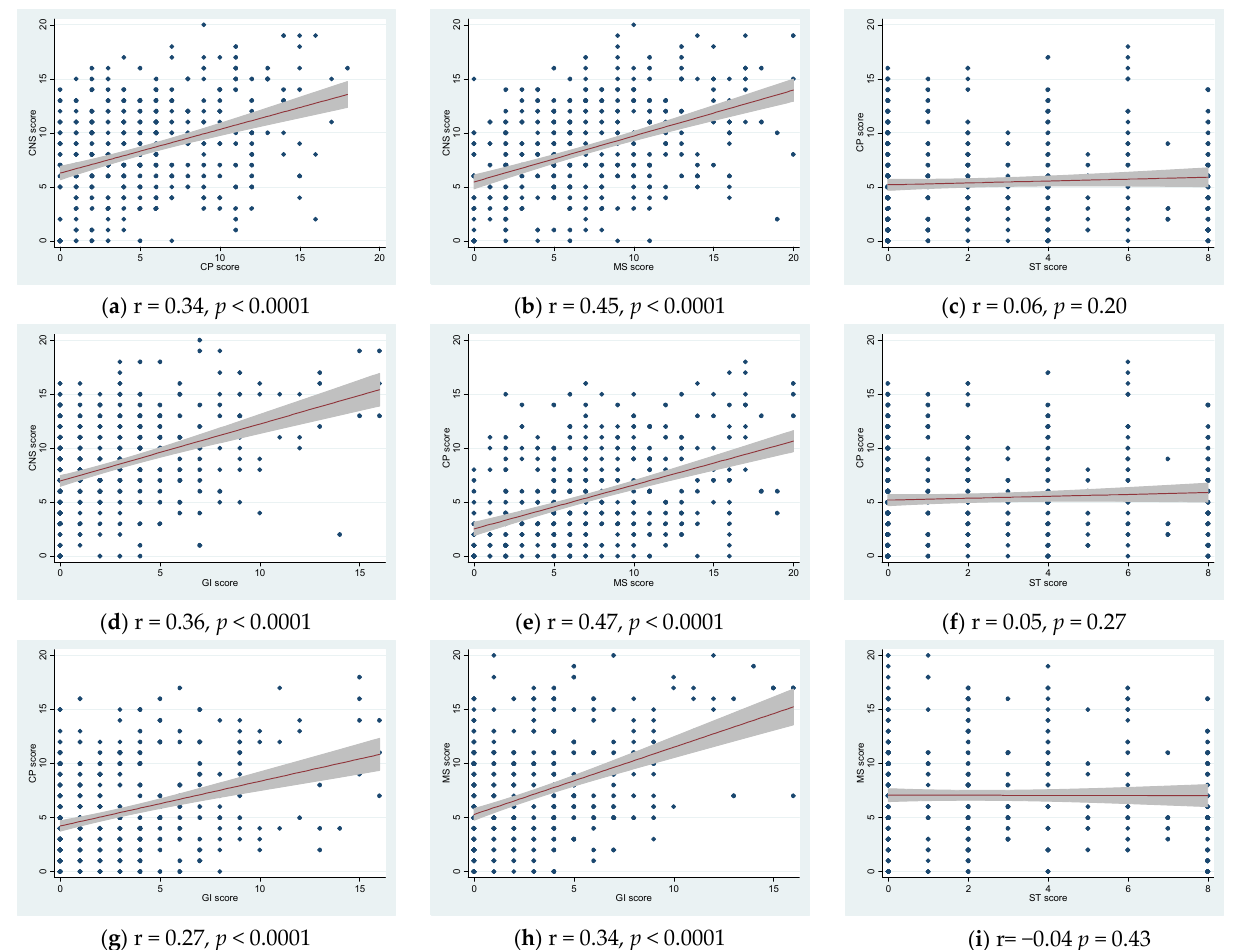
Figure 2. Correlation plots comparing organ-specific symptom scores. CNS score (central nervous system score): sum of headache, dizziness, short term memory problems, concentration difficulties and paresthesia scores (0–20). CP score (cardiopulmonary score): dyspnea at rest, dyspnea at exercise, cough, chest pain, palpitations (0–20). MS score (musculoskeletal score): sum of joint pain, joint swelling, myalgia, muscle exhaustion, physical fatigue scores (0–20). GI score (gastrointestinal score): sum of loss of appetite, alternating stool habits, diarrhea, nausea and abdominal pain scores (0–20). ST (smell and taste score: altered smell and altered taste scores (0–8). ( a – d ) CNS vs. CP, MS, ST and GI scores. ( e , g ) CP vs. MS, ST and GI score. ( h , i ) MS vs. GI and ST score. Bonferroni correction p < 0.006.